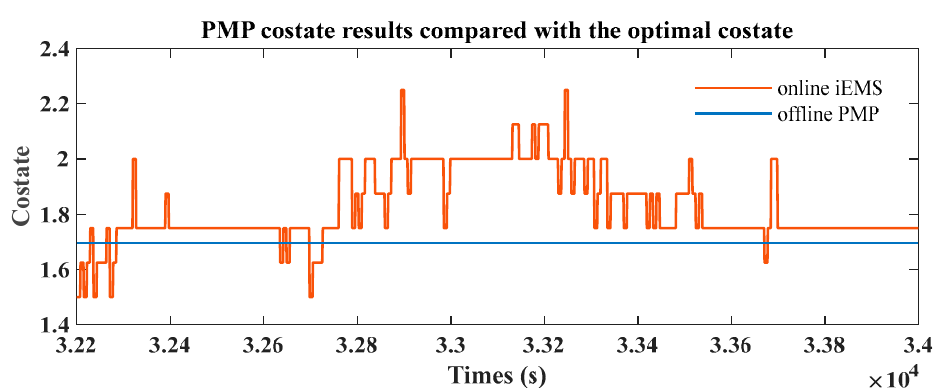
Figure 13. Online PMP costate results compared with the optimal PMP on the selected window. The results show that the online computed costate oscillates around the offline PMP, thus validating the fuel consumption optimization